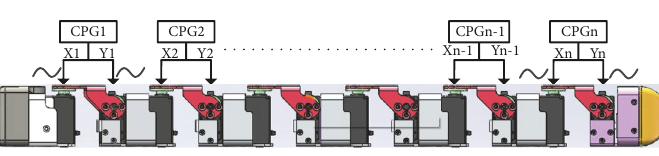
Figure 11: Convergence graph of CPG.